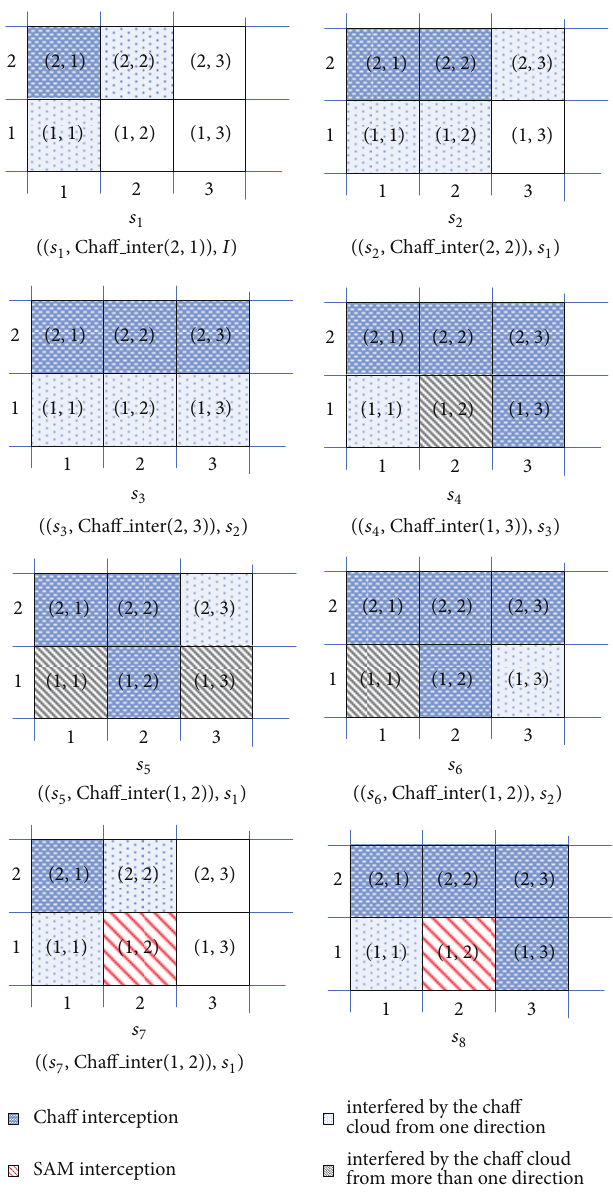
Figure 5: The example of air defense for a naval